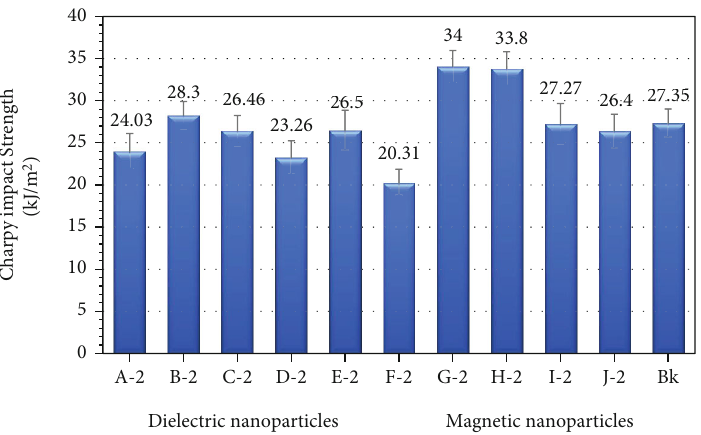
Figure 13: E ff ect of magnetic and dielectric nano fi llers on Charpy impact strength (A: MWCNTs, B: SiC, C: Gp, D: CB, E: MnO G: CoO, H: NiO, I: ZiO, J: Fe